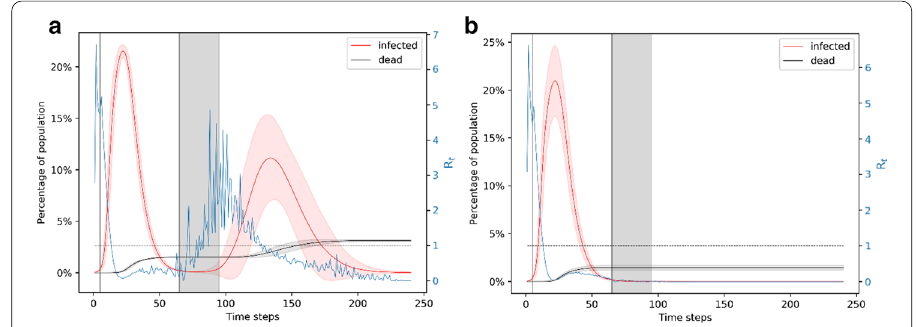
Fig. 9 Simulation of the case of phasing out of lockdown for 30 days. a Representation of the ~ 6% of simulation results that have a second wave of infection for the lockdown from day 5 to day 65 and complete normalcy resumes on day 95. b Representation of the ~ 57% of simulation results that have only one wave of infection for the lockdown from day 5 to day 65 and complete normalcy resumes on day 95. An increase in the duration of the phasing out period from 15 (see Fig. 8) to 30 leads to a significant reduction in the probability of a second wave of infection